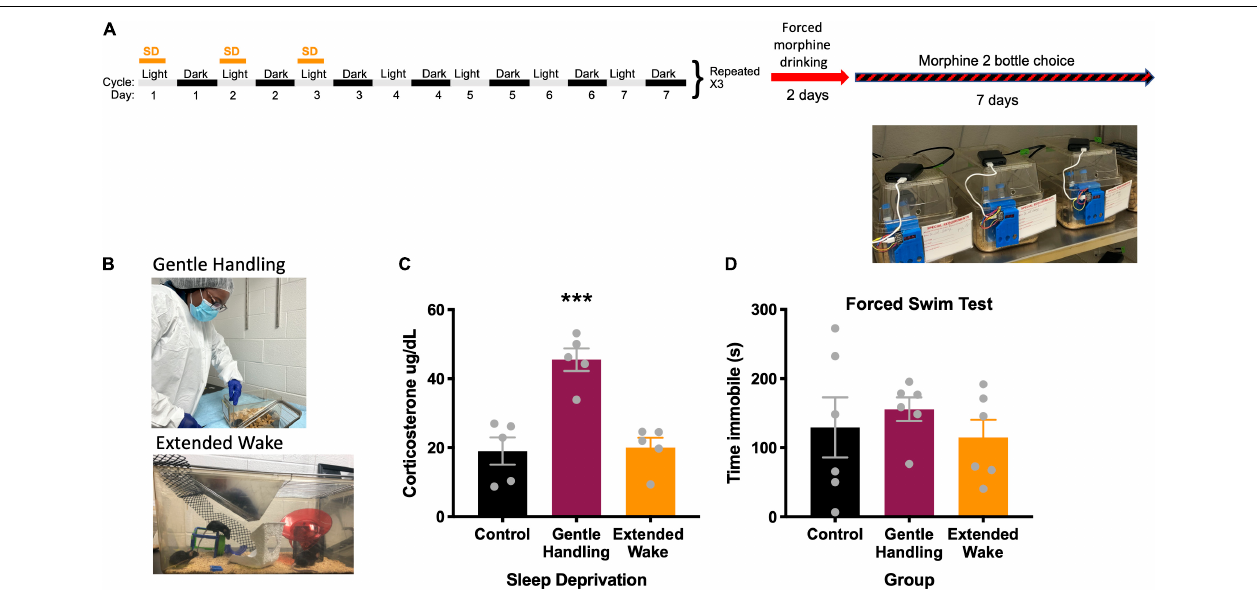
FIGURE 1 | (A) Experimental design, (B) depiction of types of sleep deprivation, (C) radioimmunoassay of corticosterone comparing types of sleep deprivation, *** indicates p < 0.001. (D) Forced swim test comparing types of sleep deprivation.